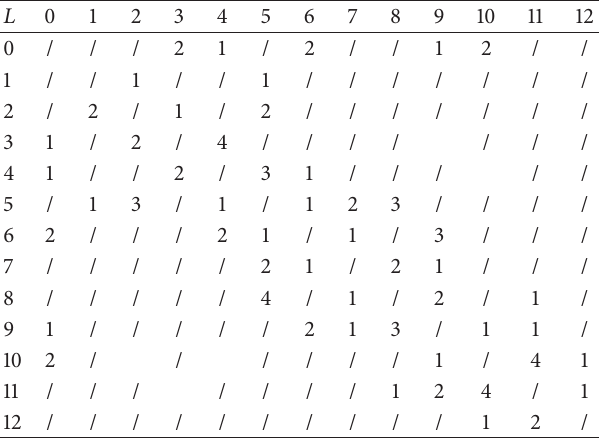
Table 3: Road class between different cities.